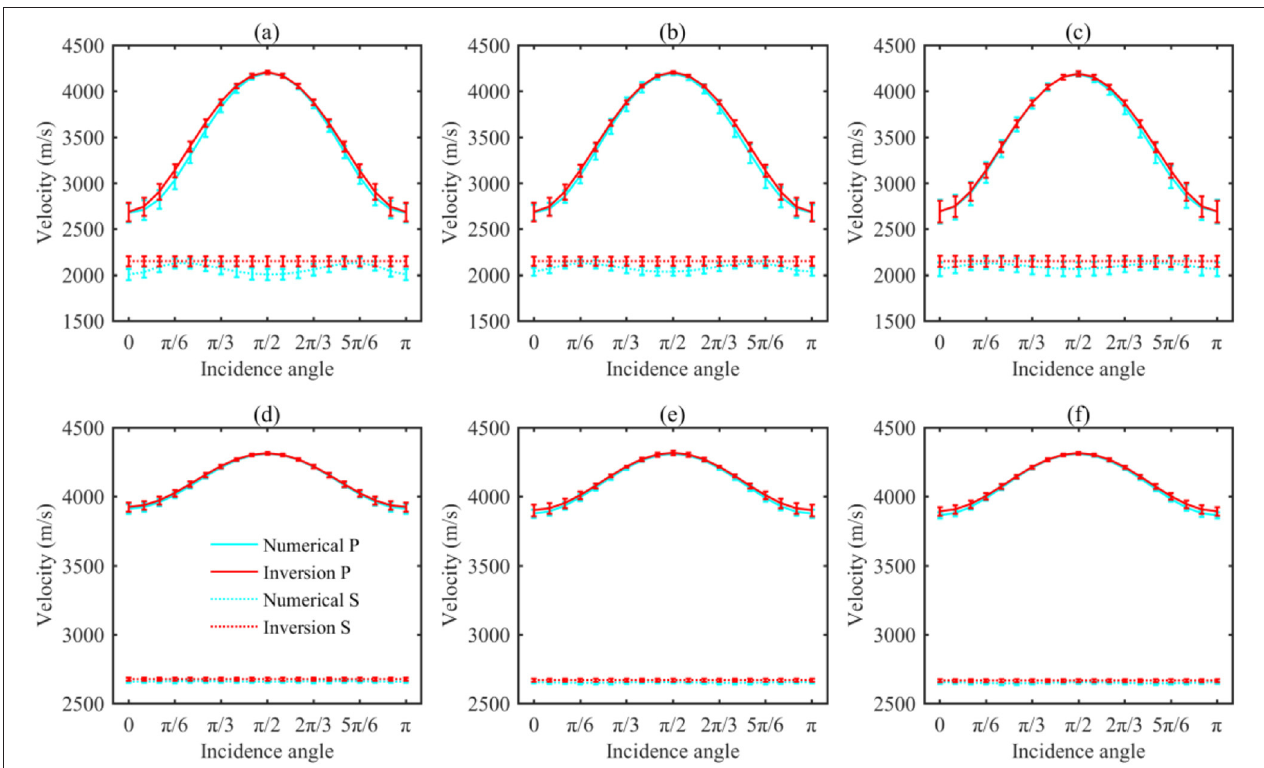
FIGURE 11 | P-wave (solid lines) and SV-wave (dashed lines) velocities as functions of different incidence angles for six kinds of models. (A) a = 1.5, 4 = 0.71; (B) a = 1.5, 4 = 0.86; (C) a = 1.5, 4 = 1; (D) a = 3, 4 = 0.71; (E) a = 3, 4 = 0.86; (F) a = 3, 4 = 1. The blue line denotes the results obtained from the numerical simulations, which is based on the real fracture parameters, while the red line represents the results obtained from NIA, but using the inverted fracture